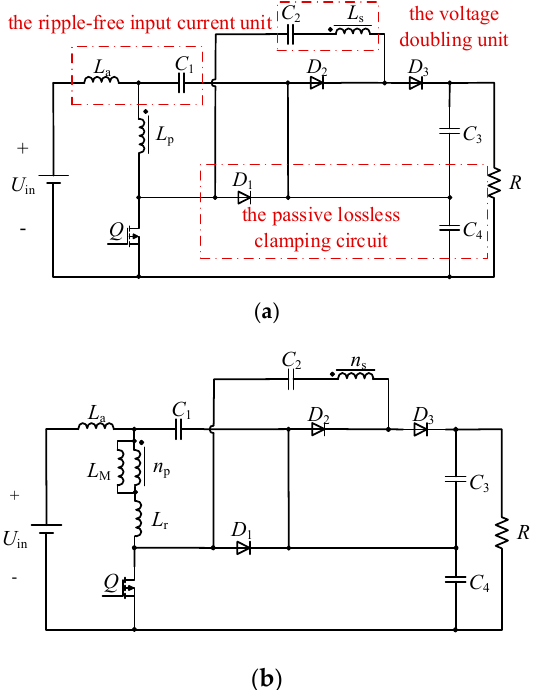
Figure 1. The proposed coupled-inductor DC-DC converter. ( a ) The topology; ( b ) the equivalent circuit.